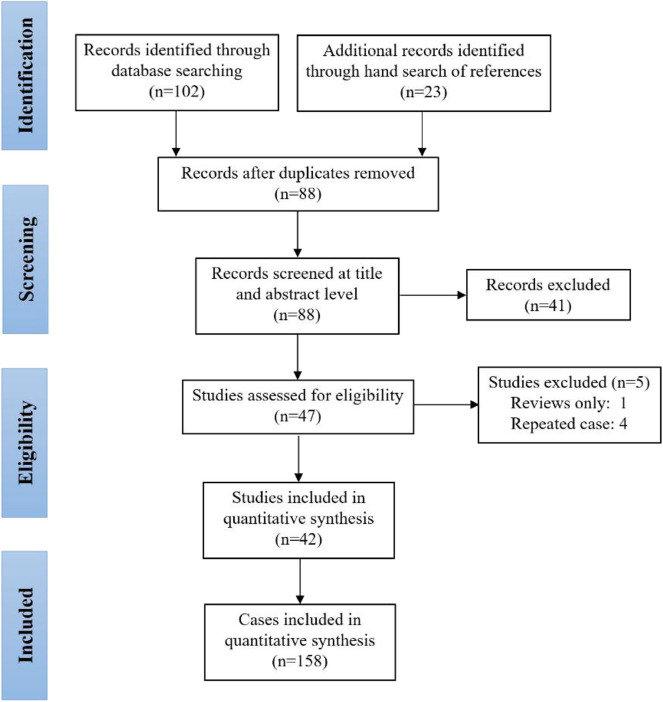
Flowchart of the search strategy and included studies.